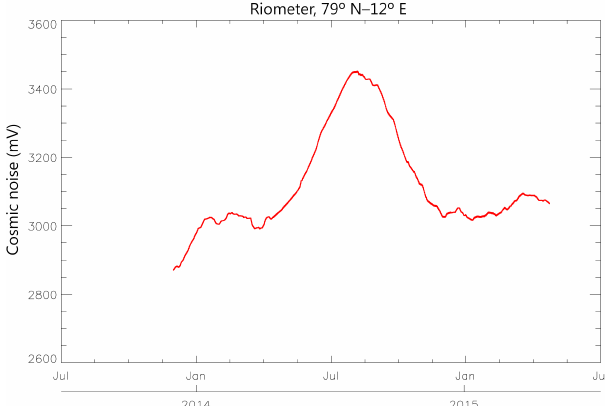
Figure 1. Cosmic noise at 40MHz measured by riometer at Ny- Ålesund, 79 ◦ N, 12 ◦ E. Original data at 2s time resolution have been smoothed by a 1-month boxcar to show both the overall data coverage and seasonal